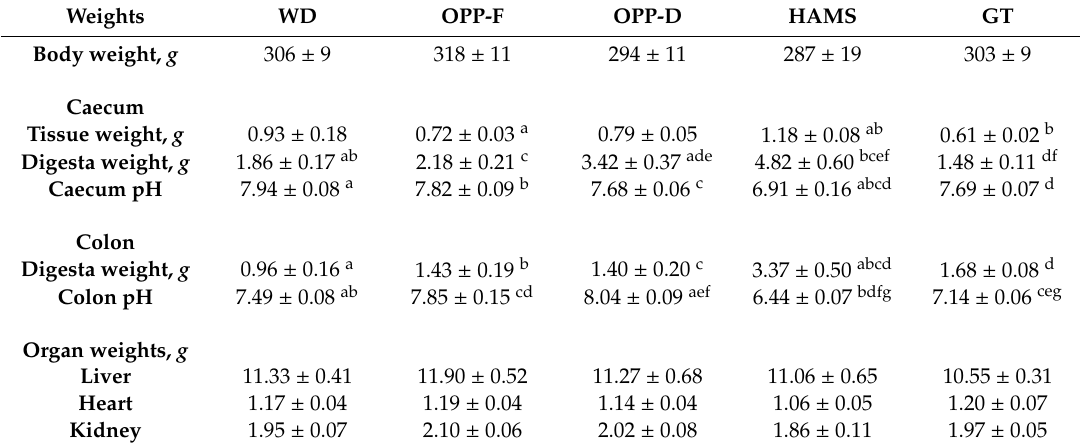
Table 2. E ff ects of dietary treatment on final body, organ, gut tissue and digesta weights, and digesta pH 1 .